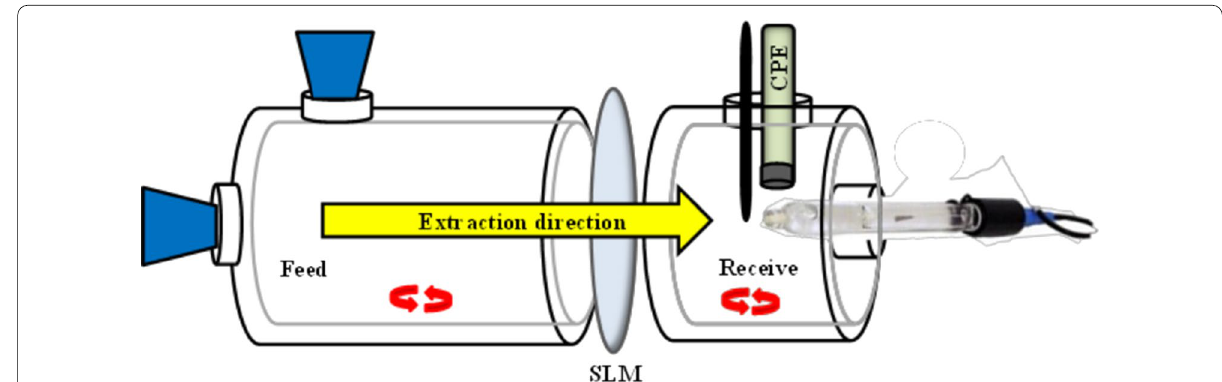
Fig. 9 Diagram shape of removal setup by utilizing supported liquid membrane (Romero-Cano et al. 2019)